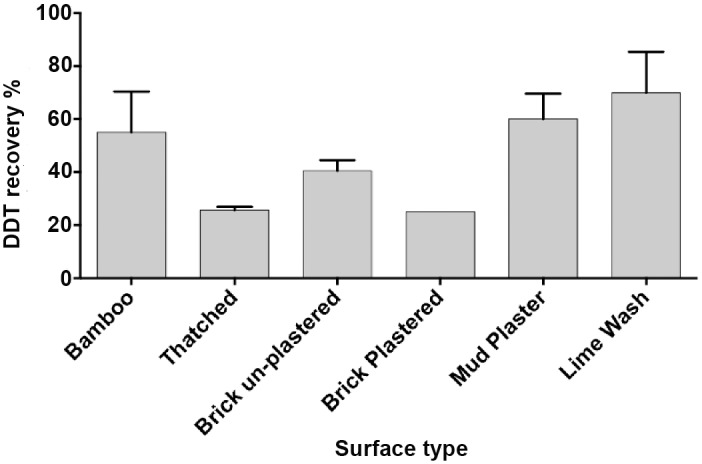
Comparison of DDT recovery by Bostik adhesive discs from different surface types.Error bars represent standard deviation from four independent replicates.